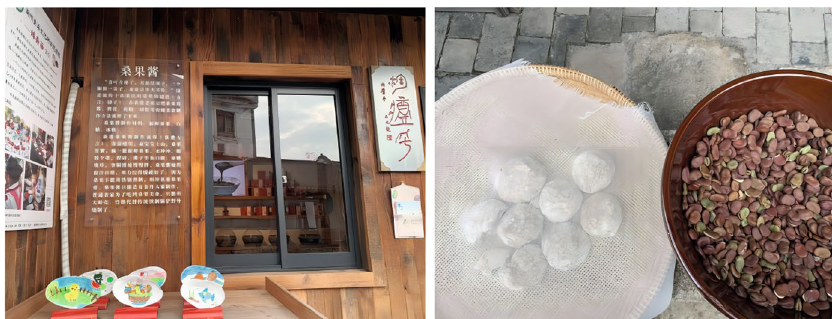
Fig. 9 Mulberry jam explanation board and production display (Source: the authors)